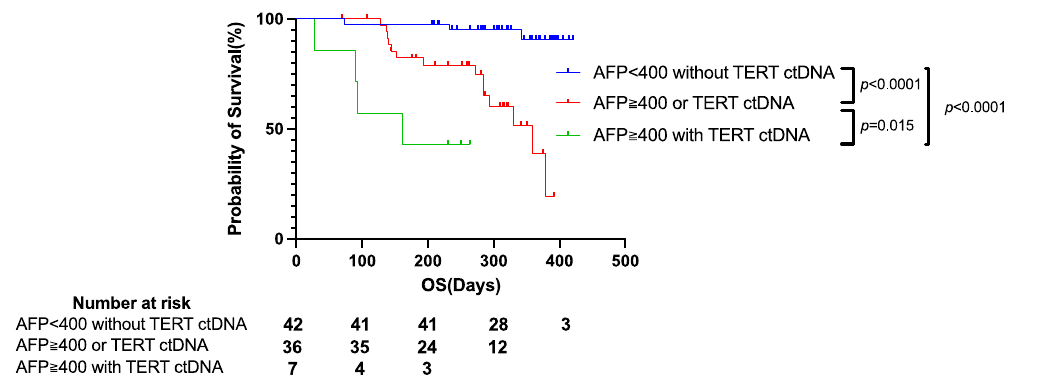
Figure 5. TERT ctDNA mutation and AFP level stratify prognosis of u-HCC patients treated with combination immunotherapy. Total 85 u-HCC patients treated with Atezo/Bev were divided into three groups based on the AFP levels and the presence or absence of TERT ctDNA mutation (AFP levels > 400 ng/mL with TERT ctDNA mutation, AFP levels > 400 ng/mL or TERT ctDNA mutation, AFP levels < 400 ng/mL without TERT ctDNA mutation). The Kaplan–Meier curves of overall survival (OS) for each group. ctDNA, circulating tumor DNA; u-HCC, unresectable hepatocellular carcinoma; Atezo/Bev, Atezolizumab and bevacizumab.